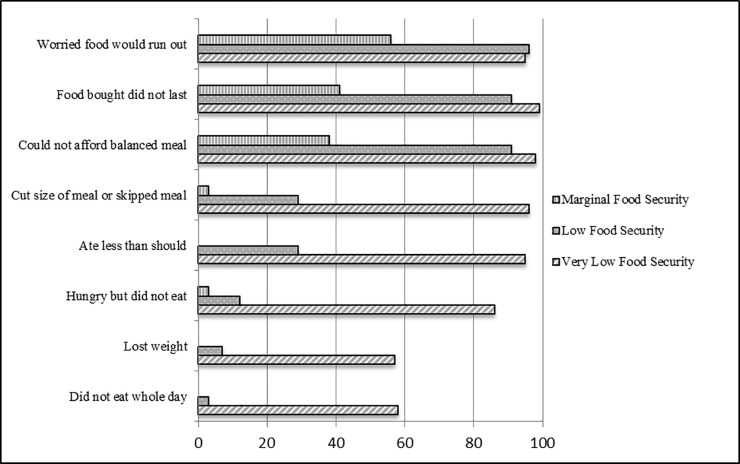
Percentage of adults on probation reporting each indicator of food insecurity in the last 30 days, by food security status (n = 304), Rhode Island, 2016.For each of the ten indicators for food insecurity, the percentages of each level of food security that reported an affirmative response to each indicator are shown. For the indicators, cut the size of a meal or skipped a meal and did not eat for a whole day, the mean number of days that individuals that provided an affirmative response to these indicators are represented by food security level.